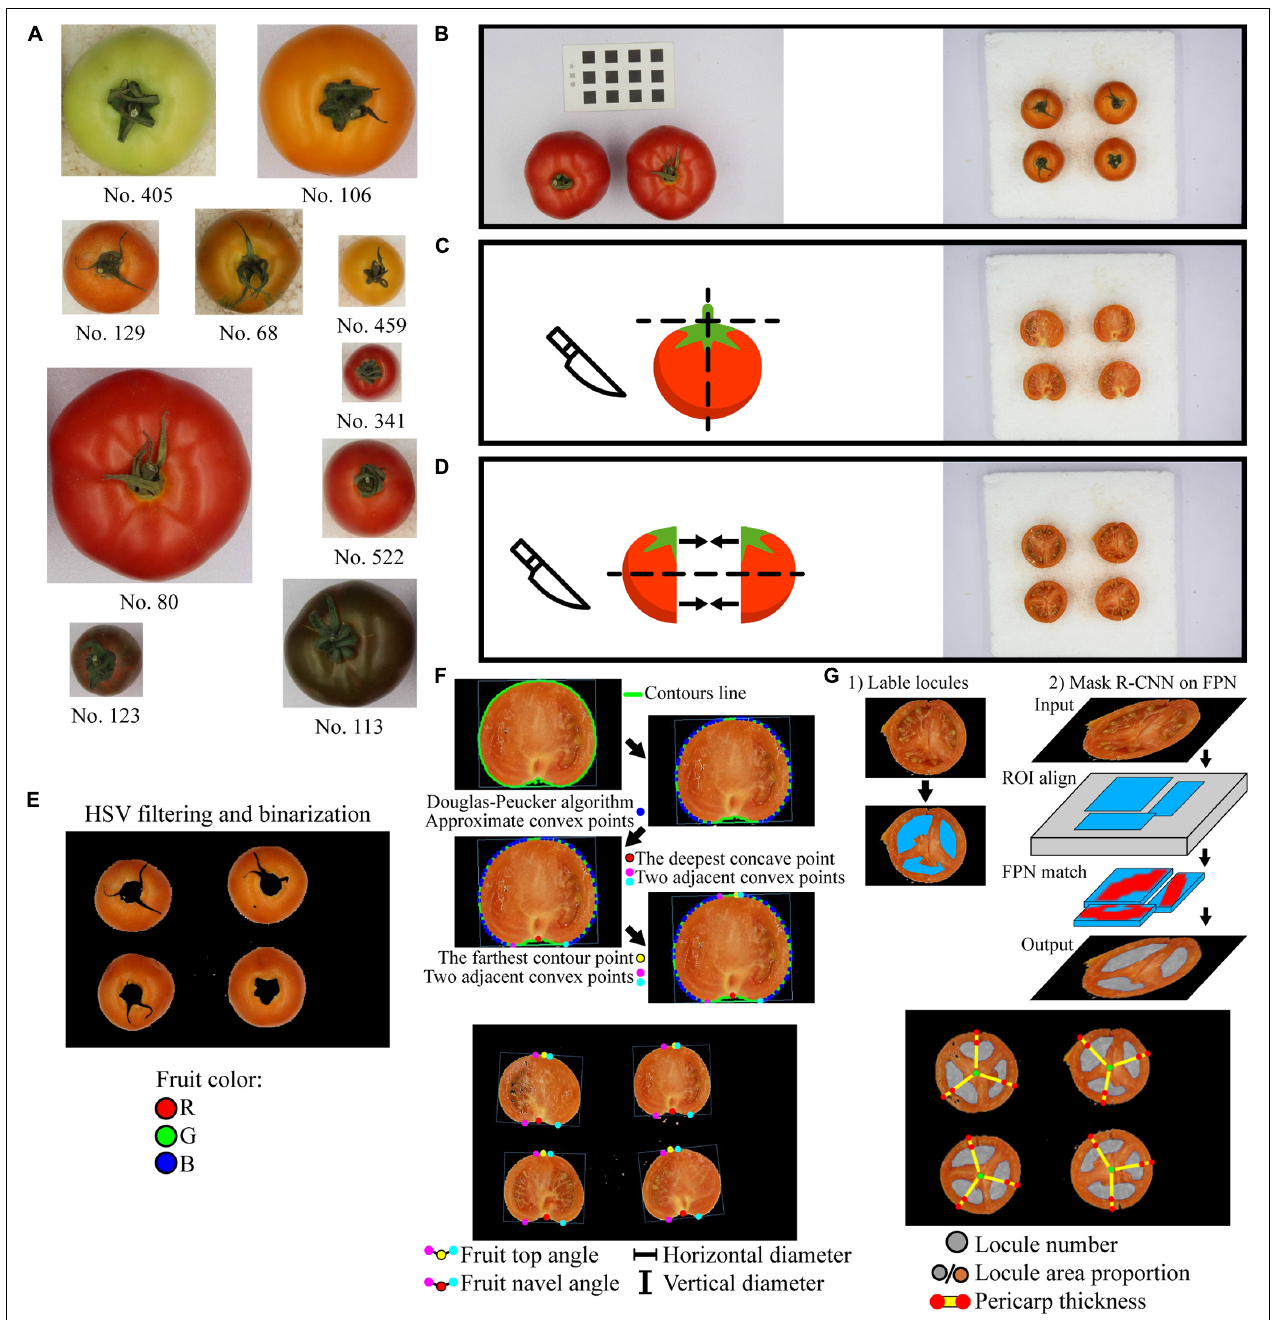
FIGURE 1 | Tomato samples and image acquisition process. (A) Tomato samples, images are proportional; (B) Image acquisition of ruler card and the intact fruit; (C) Image acquisition of the vertical cut; (D) Image acquisition of the horizontal cut; the same fruit of vertical cut is cut then joint the corresponding horizontal parts together. (E) The extraction of the fruit average color Red, Green, and Blue (R, G, B) values from the intact fruit images; (F) Fruit top angle, fruit navel angle, horizontal diameter, and vertical diameter extraction from the vertical cut images; the red, yellow, magenta, and cyan points are the navel point, the top point, the left, and the right adjacent convex points, respectively; (G) Fruit locule number, locule area proportion, and pericarp thickness extraction from the horizontal cut images; the gray and orange circles refer to the locule segmentation and the horizontal cut section, the green points are the center of the horizontal cut section, and the red points are the intersections of the lines and the